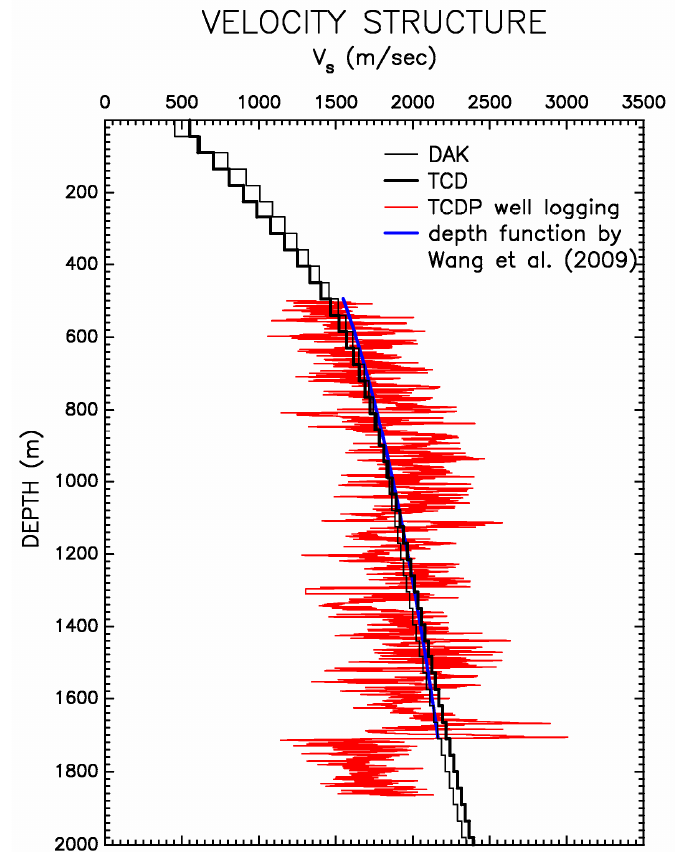
Figure 4. S-wave velocity structures (adopted from Wu and Huang [11]) estimated using the differ- ential inversion technique at sites DAK (thin black line) and TCD (thick black line) compared with those from the TCDP velocity logs (red line) and the depth function (blue line; Wang et al. [24]).